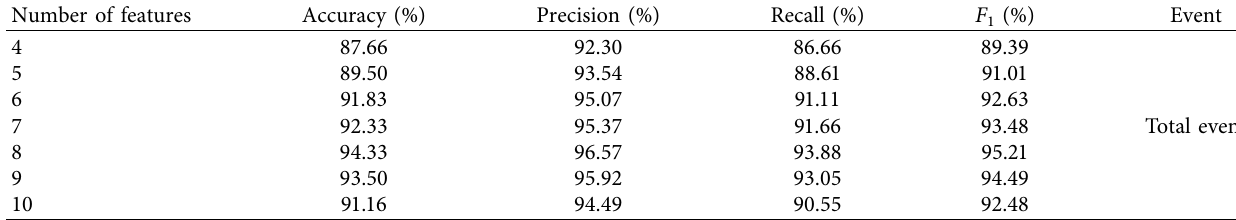
Table 6: Model performance with different indicators in total event.